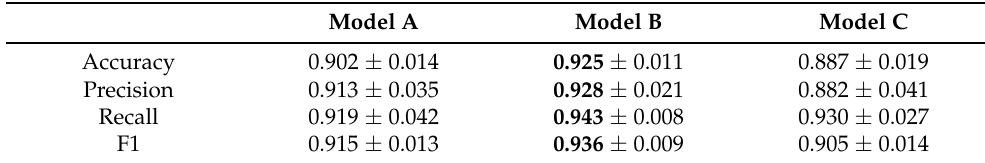
Table 4. Performance of three architectures tested on lab images not included in the training set. Reported values are the average and standard deviation over the five replicas shown in Figure 5. The best performer in each row is shown in bold.